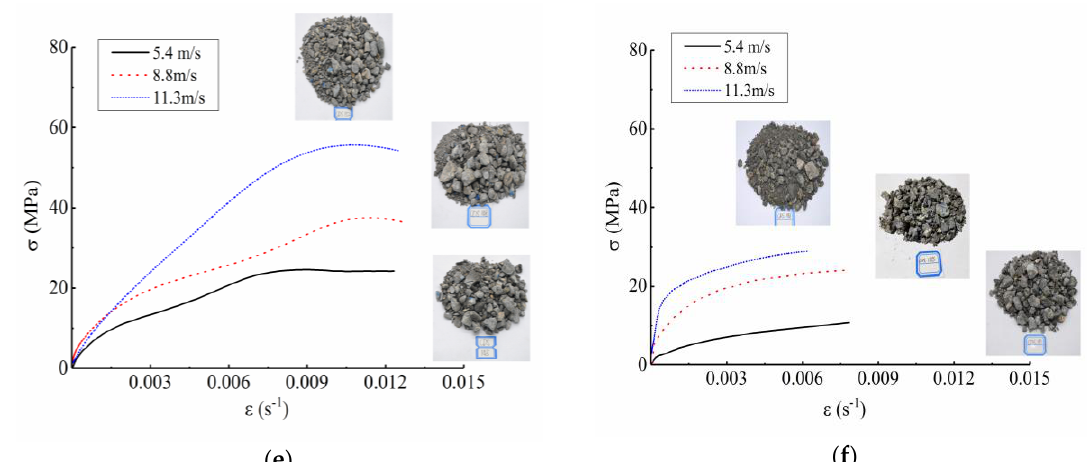
Figure 5. Dynamic failure modes and stress-strain curves of concrete at different impact speeds. ( a ) 0 freeze-thaw cycle; ( b ) 10 freeze-thaw cycles; ( c ) 20 freeze-thaw cycles; ( d ) 30 freeze-thaw cycles; ( e ) 40 freeze-thaw cycles; ( f ) 50 freeze-thaw cycles.